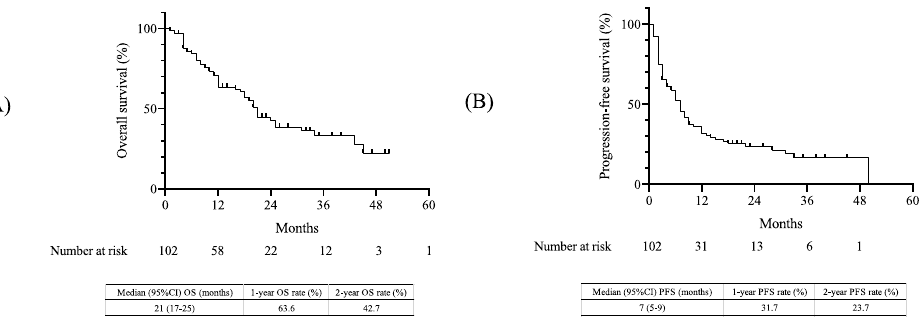
Figure 1. Kaplan–Meier curves in the overall population: ( A ) OS and ( B ) PFS. OS, overall survival; PFS, progression-free survival; CI, confidence interval.